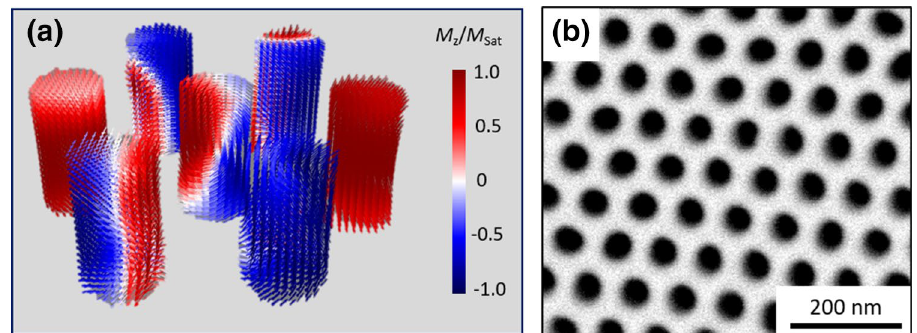
Figure 2. ( a ) 3D representation of the magnetic configuration during reversal of the simulated Ni NW arrays with 100 nm in length illustrating curling rotation with the formation of a vertical vortex when applying the magnetic field along the z-direction (parallel to the NWs’ long axis). ( b ) SEM top view of the template used, evidencing the ordered hexagonal